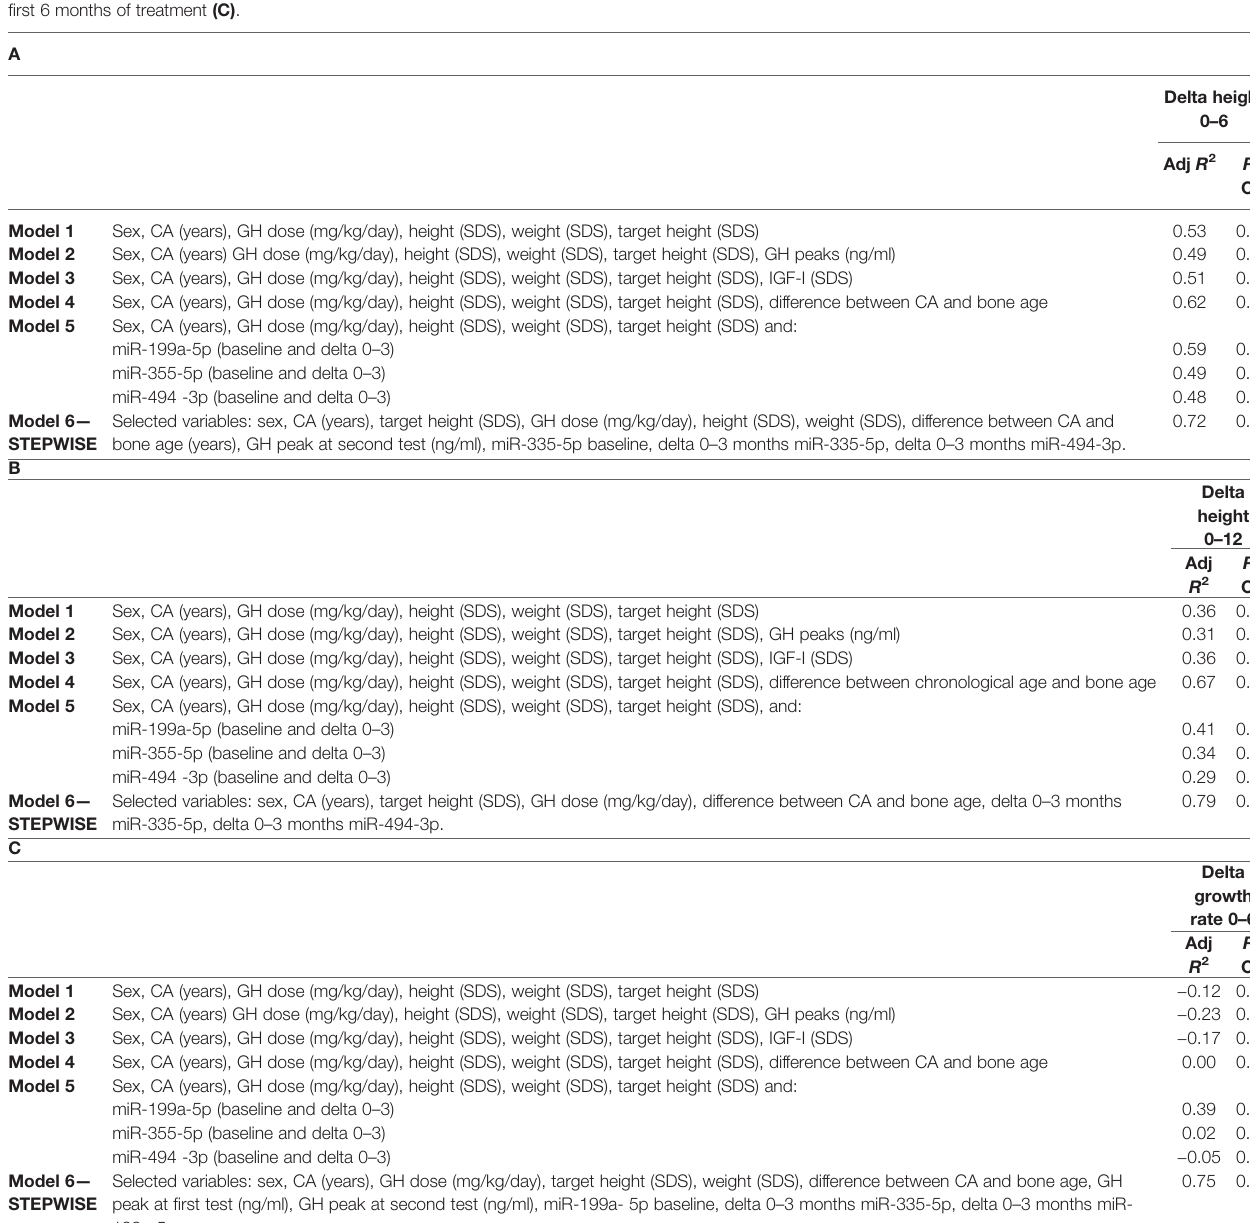
TABLE 4 | Multiple regression models to predict the change in height SDS during the fi rst 6 months (A) and 12 months (B) of treatment, and growth velocity during the fi rst 6 months of treatment (C)